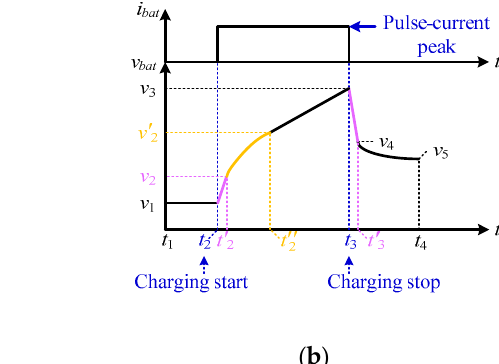
Figure 2. Parameter measurement of PNGV battery model. ( a ) Measurement configuration diagram. ( b ) Voltage − time characteristic using pulse-current charge.